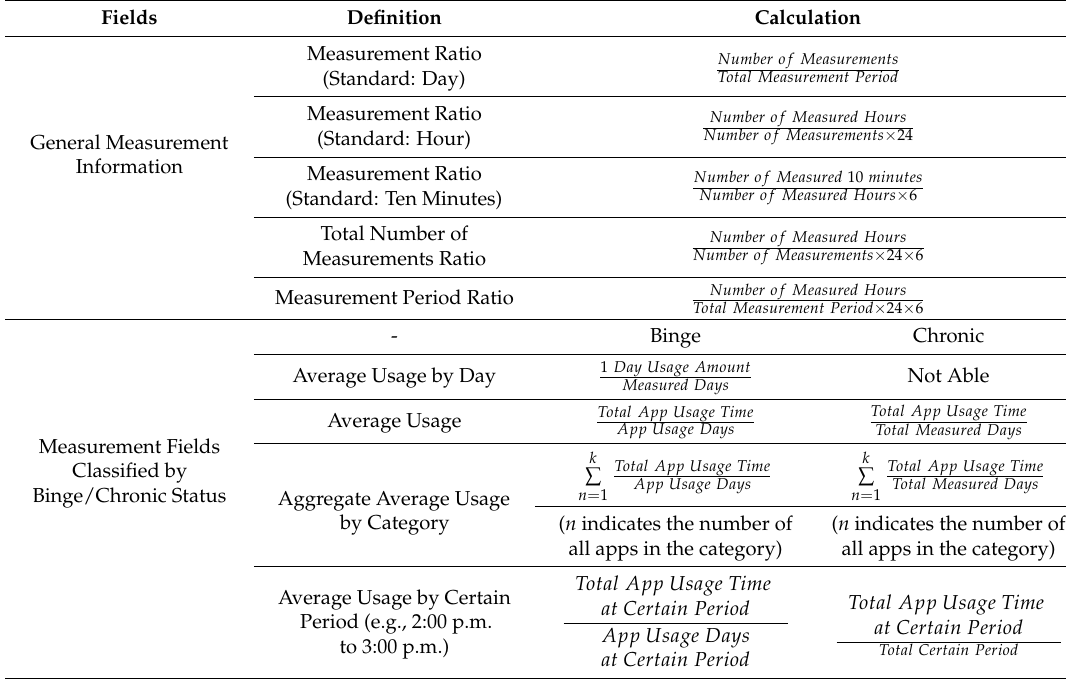
Table 1. Data quality